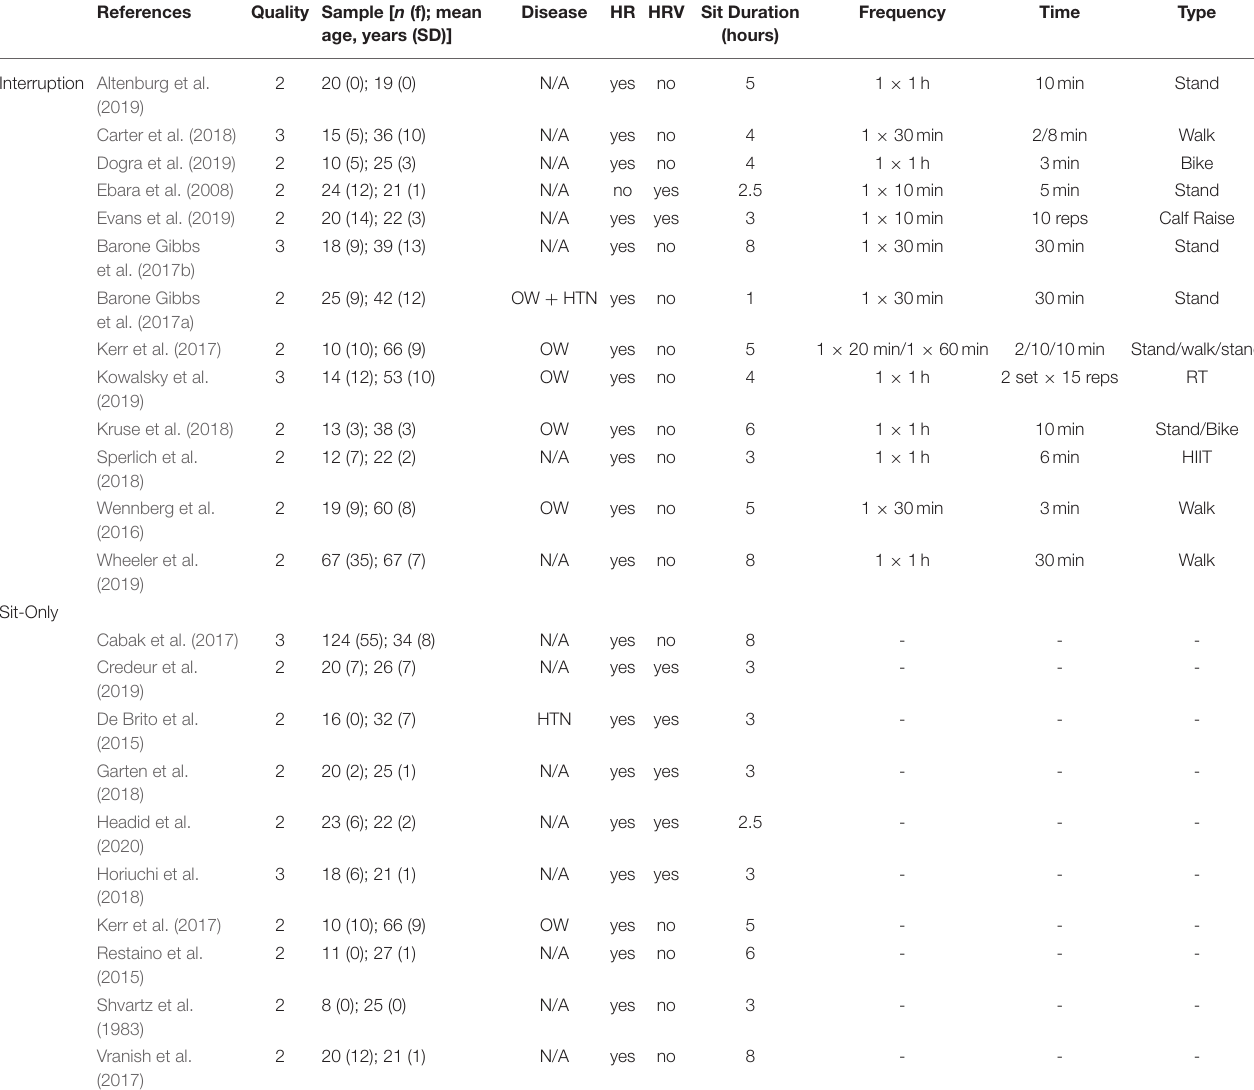
TABLE 1 | Characteristics of included